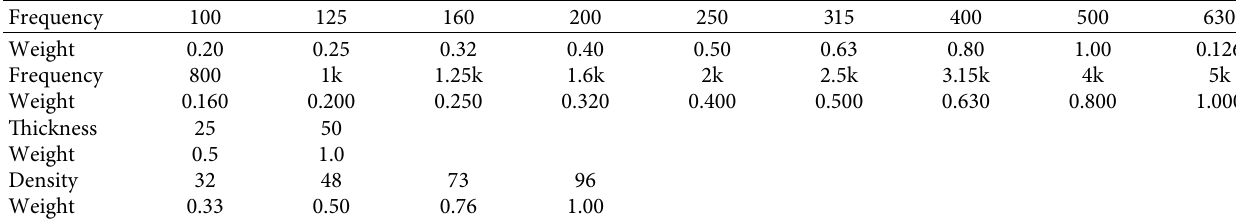
Table 4: Variable weight adjustment.